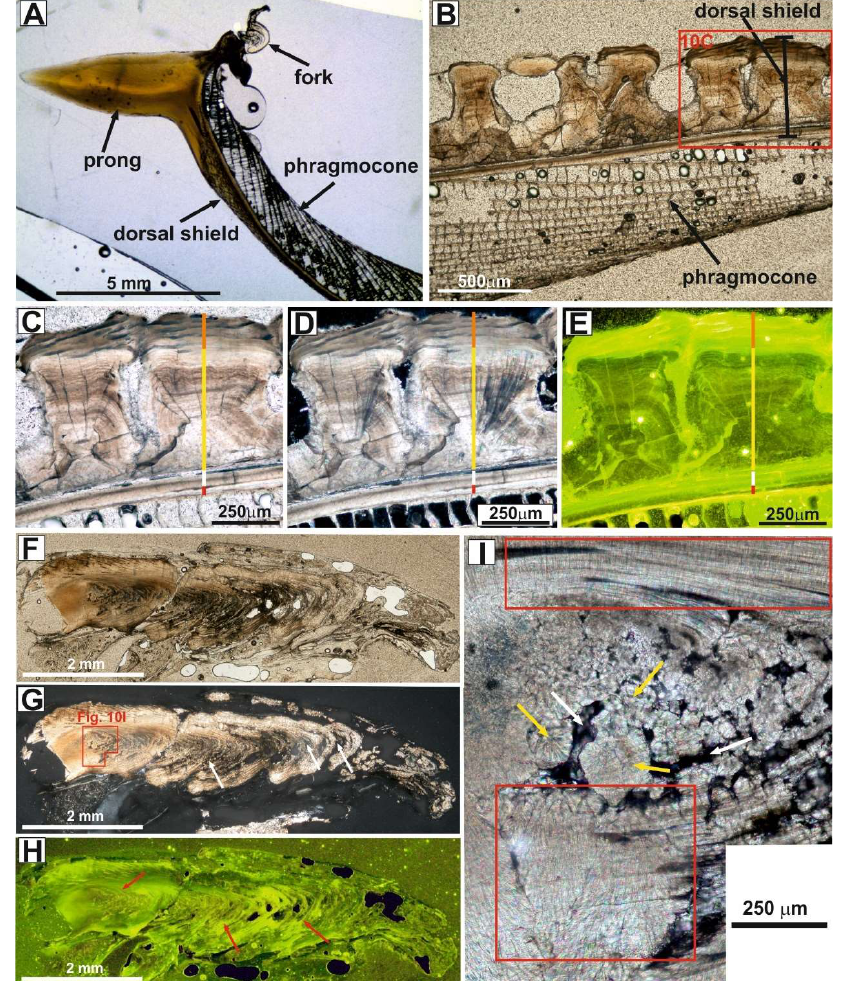
Figure 10. Thin sections of Sepia . ( A ) S. orbignyana . ( B – I ) S. officinalis . ( A ) Cuttlebone of S. orbignyana (SP-12) under magnification glasses showing the phragmocone, the dorsal shield and the prong. ( B ) Phragmocone and dorsal shield under TL microscopy (SP-07) with the tubercles. ( C – E ) Detailed view of ( B ), under TL ( C ), PL ( D ), and FL ( E ). The dorsal shield comprises 3 layers: the inner (red bar), displaying weak FL, the middle layer (white bar), displaying intense FL, and the outer layer (yellow and orange bars). The outer layer, which forms the tubercles and displays undulose extinction and concentric layering, comprises an inner part (yellow bar) composed of radially arranged aragonite crystals displaying non- to weak FL (despite its internal FL concentric pattern), and an outer part (orange bar) displaying very intense FL. ( F – I ) Longitudinal thin section of the prong under TL ( A ), PL ( B , I ) and FL ( C ) microscopy (SP-01). The red square on G represents the area shown in ( I ). Note the concentric growth pattern of the prong (red arrows in ( H )), and the high intra-skeletal porosity (white arrows in ( G ) and ( I )), which is enhanced in the apical area. Spherulites are developed in the inner part of the prong (yellow arrows), displaying radially arranged aragonite crystals and undulose extinction. Towards the outer wall of the prong, aragonite crystals become longer and radially arranged, displaying undulose extinction and traversing the concentric layering (red squares). Modified from Figure 7 of Benito et al. [31], who erroneously assigned this specimen to S.